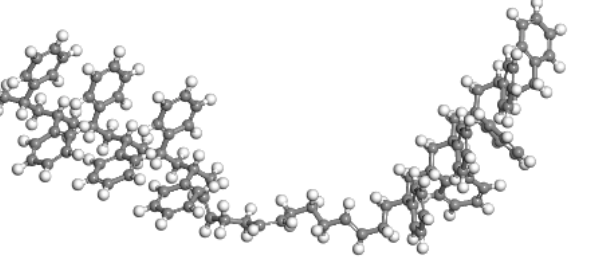
Figure 3. SBS modifier molecular model.